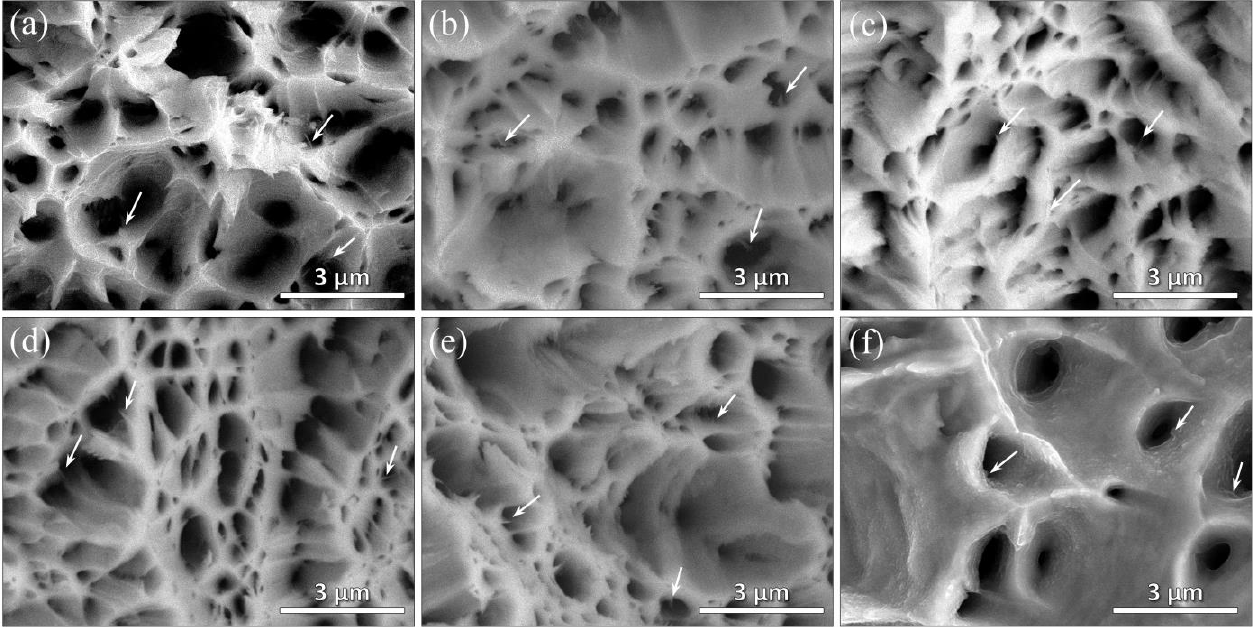
Figure 16. Fracture surface of the composites with different drawing reductions: ( a ) 36.0%, ( b ) 67.3%, ( c ) 73.6%, ( d ) 81.6%, ( e ) 91.3%, ( f ) 99.7%.